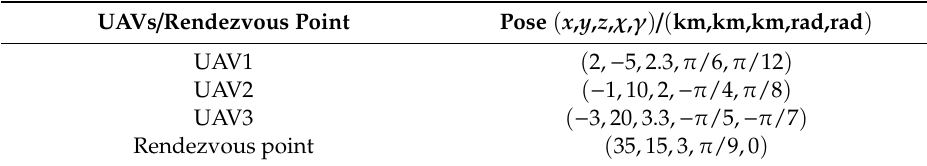
Table 5. Poses at UAV starting points and rendezvous point (3-D).